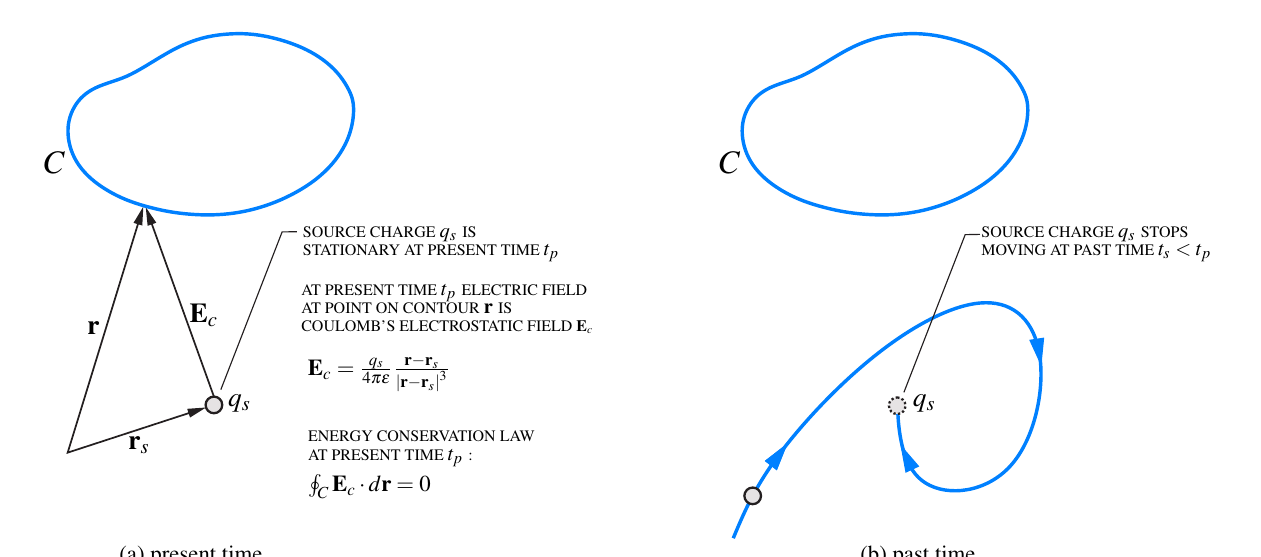
Figure 1. In ( a ) the source charge q s is at rest at present time t p . Each point on closed contour C is affected by Coulomb’s electrostatic field E c . Energy conservation principle at present time is along arbitrary path and it stops at past time t s < t p . Dynamic energy conservation principle valid in the past is assumed to be unknown when source charge was